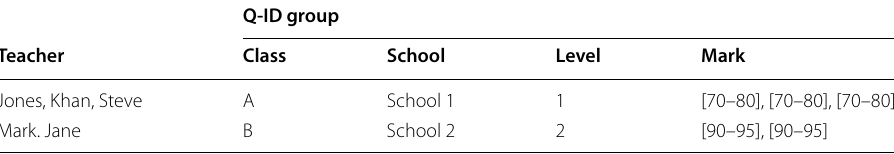
Table 1 Grouped and anonymized table